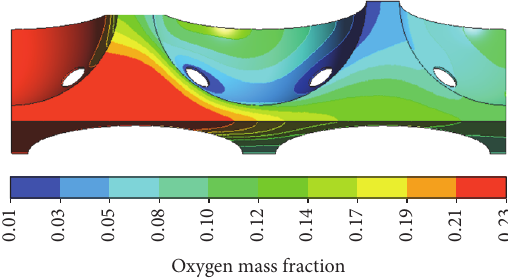
Figure 5: O 2 mass fraction near the graphite sphere.